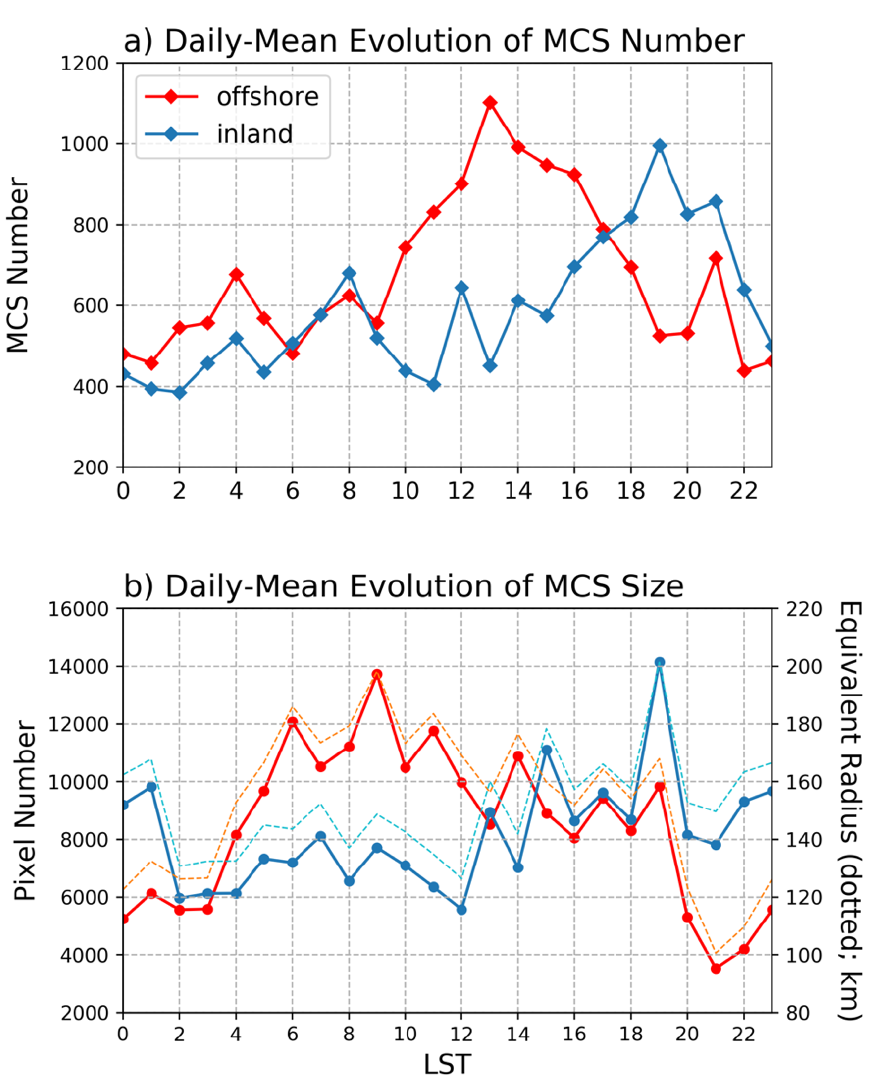
Figure 10. Daily mean evolution of ( a ) the number and ( b ) size of mesoscale convective systems based on the SAST output over the SCCA offshore and inland regions, as denoted by red and blue markers, respectively. Furthermore, for strong MCSs with a duration over 12 h, the starting and ending points are marked by purple and gray triangles in Figure 11, respectively. Ending points primarily appeared on panels 21–24 LST and 15–18 LST, whereas several starting points (marked with purple crosses) were found on the 03–06 LST panel over the offshore coast. In that specific panel, two ending points appeared over the inland region, indicating the disappearance of two convective events and the possible start of events over other regions. When further compared with the previous framework from 00 to 03 LST, where the MCSs were concentrated over the inland region and no starting or ending points were observed over SCCA (black box), an MCS migration from inland to offshore was found to occur at ~03 LST. This migration may have been caused or facilitated by the background environment during a specific period. Subsequently (as described in the next section), we examined the meteorological conditions to obtain additional details and identify possible causal